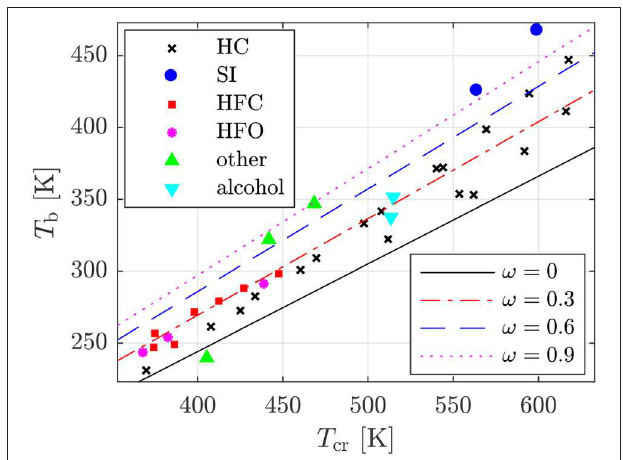
FIGURE 5 | Critical temperature T cr and normal-boiling temperature T b of common working fluids available within the REFPROP program (markers) and the same parameters obtained using the Peng-Robinson equation of state for different values of ω with p cr = 30 bar (lines). HC, hydrocarbons; SI, siloxanes; HFC, hydrofluorocarbons; HFO,